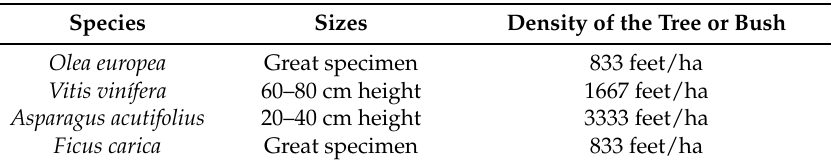
Table 9. Species for agroforestry plantation.